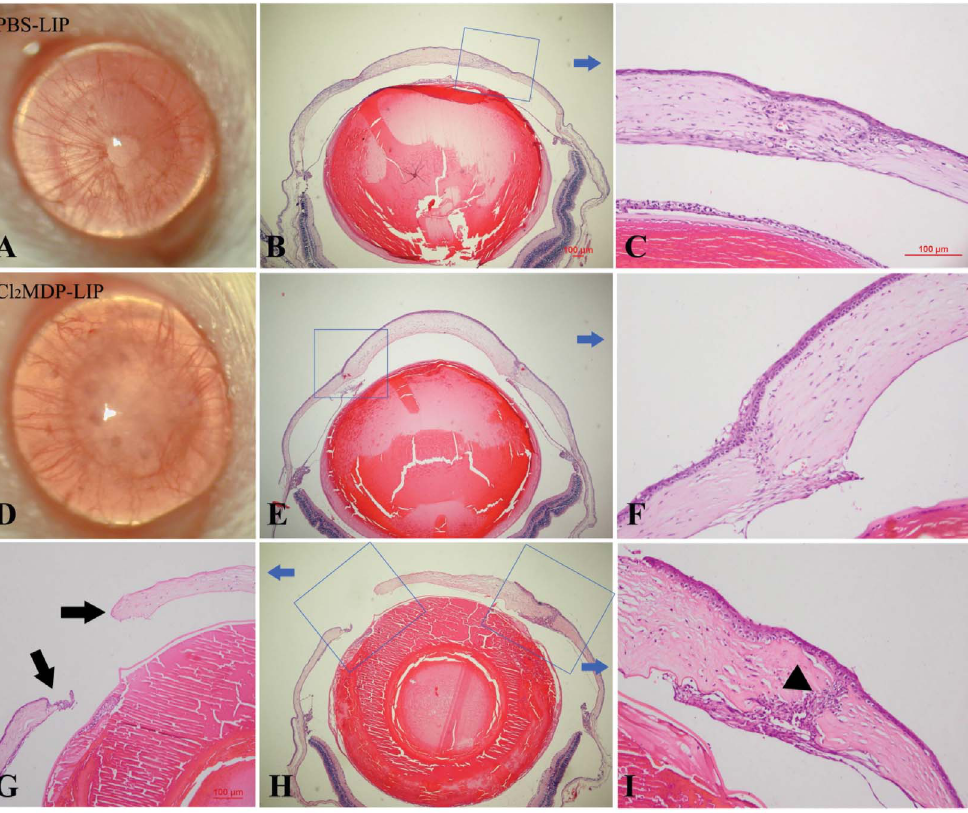
Figure 5. Effect of macrophage depletion on corneal wound healing. In mice injected with PBS-LIP, the graft healed well at 14 days after surgery (A), with apparent inflammatory cells and fibroblasts in the junction region between the graft and recipient cornea (B, C), and the collagen fibers were dense and distributed parallel to stromal layers (C). However, the graft showed apparent edema (D) and space between the recipient bed (E) in Cl 2 MDP-LIP-treated mice. Few inflammatory cells and fibroblasts were recruited into the junction, the collagen fibers were irregularly distributed (F), the onset of wound dehiscence was observed, with the graft detached from the recipient cornea (G, H), and there was ingrowth of corneal epithelial cells into the junction (I).